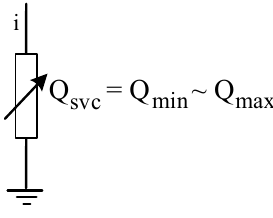
Figure 2. Single-line diagram of a Static Var Compensator model.